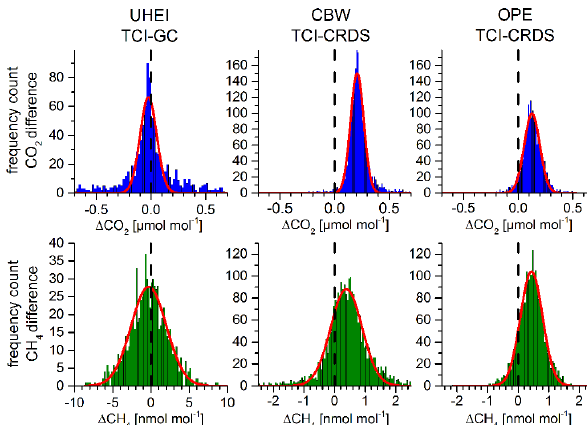
Fig. 5. Histograms of the individual CO 2 (upper panel) and CH 4 (lower panel) differences for the different stations. For each histogram a Gaussian distribution is fitted and given in red. Note the different scale for CH 4 in